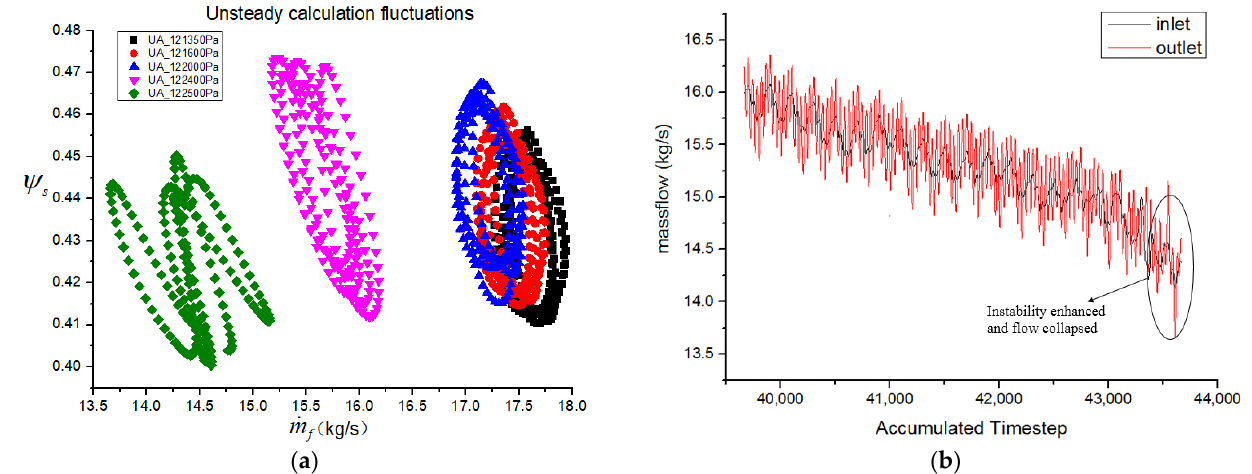
Figure 14. Unsteady parameter fluctuation. ( a ) Parameter fluctuation under various working condi- tions with the U_A model and ( b ) flow-monitoring curve of U_A_122500Pa.